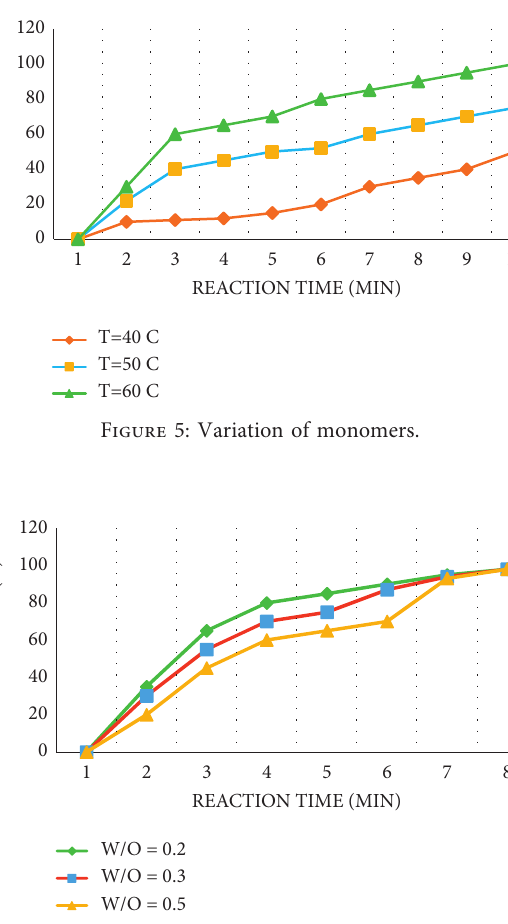
Figure 6: W/O reaction.